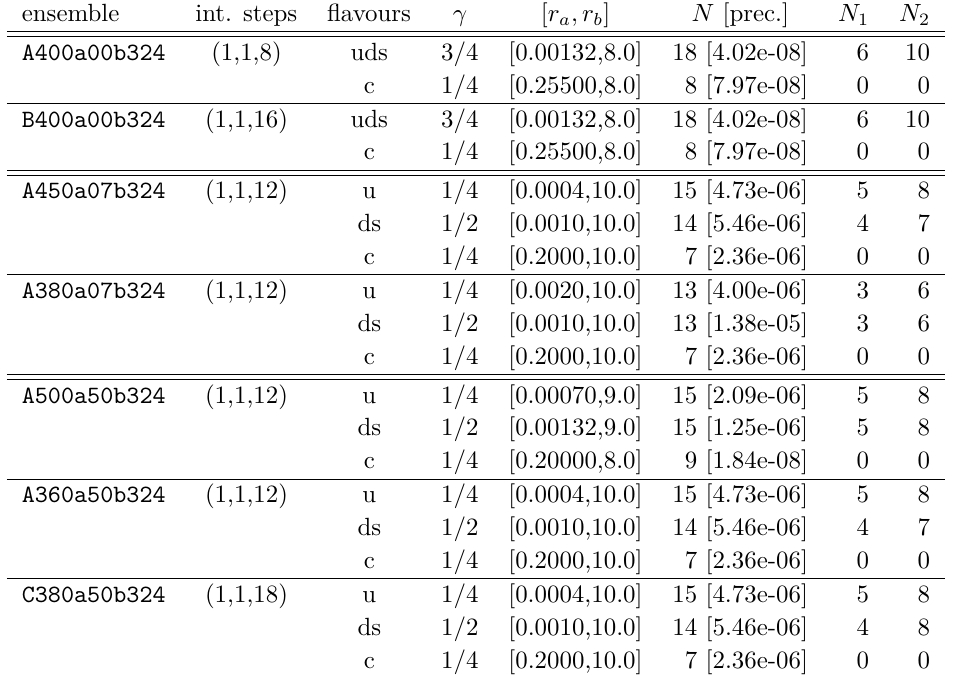
Table 11 . Parameters defining the integration scheme and the pseudofermion actions. In the second column ( int. steps ) we report the number of integration steps for the innermost, intermediate and outermost integration levels. For each degenerate multiplet of quarks specified in the third column ( flavours ), we use a rational approximation for the operator ( ˆ D † ˆ D ) − γ . We report the exponent γ , the chosen range [ r a , r b ] , the order ( N, N ) of the rational approximation, and its relative uniform precision. N 1 denotes the number of factors integrated in the outermost level of the integrator, and N 2 denotes the number of factors that have been split into independent pseudofermion